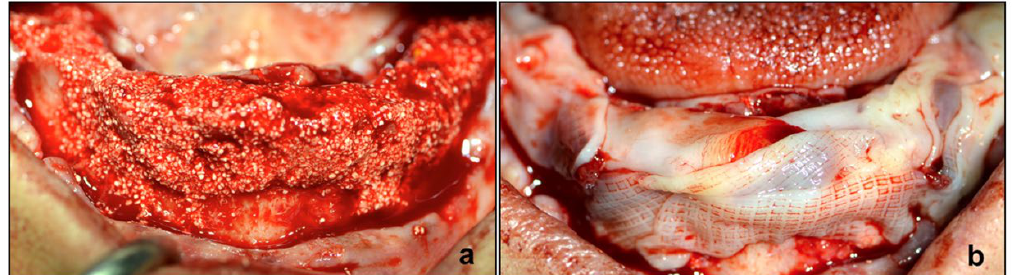
Figure 5. Bone graft and concentrated growth factor (CGF) combined with melatonin. ( a ) Biomaterial blended with CGF red component in situ and ( b ) CGF membrane plus melatonin in situ.